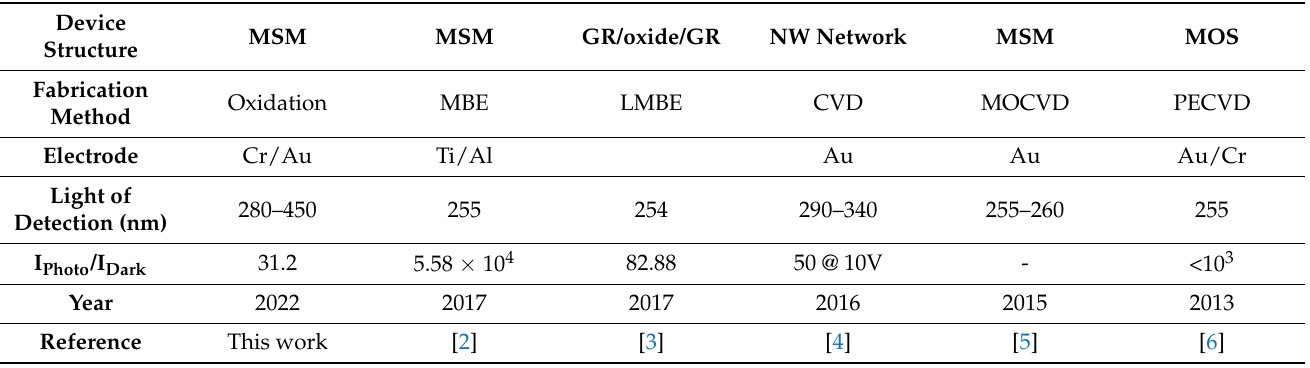
Table 4. Summary of β -Ga 2 O 3 device performance of the present device and other previously reported UV